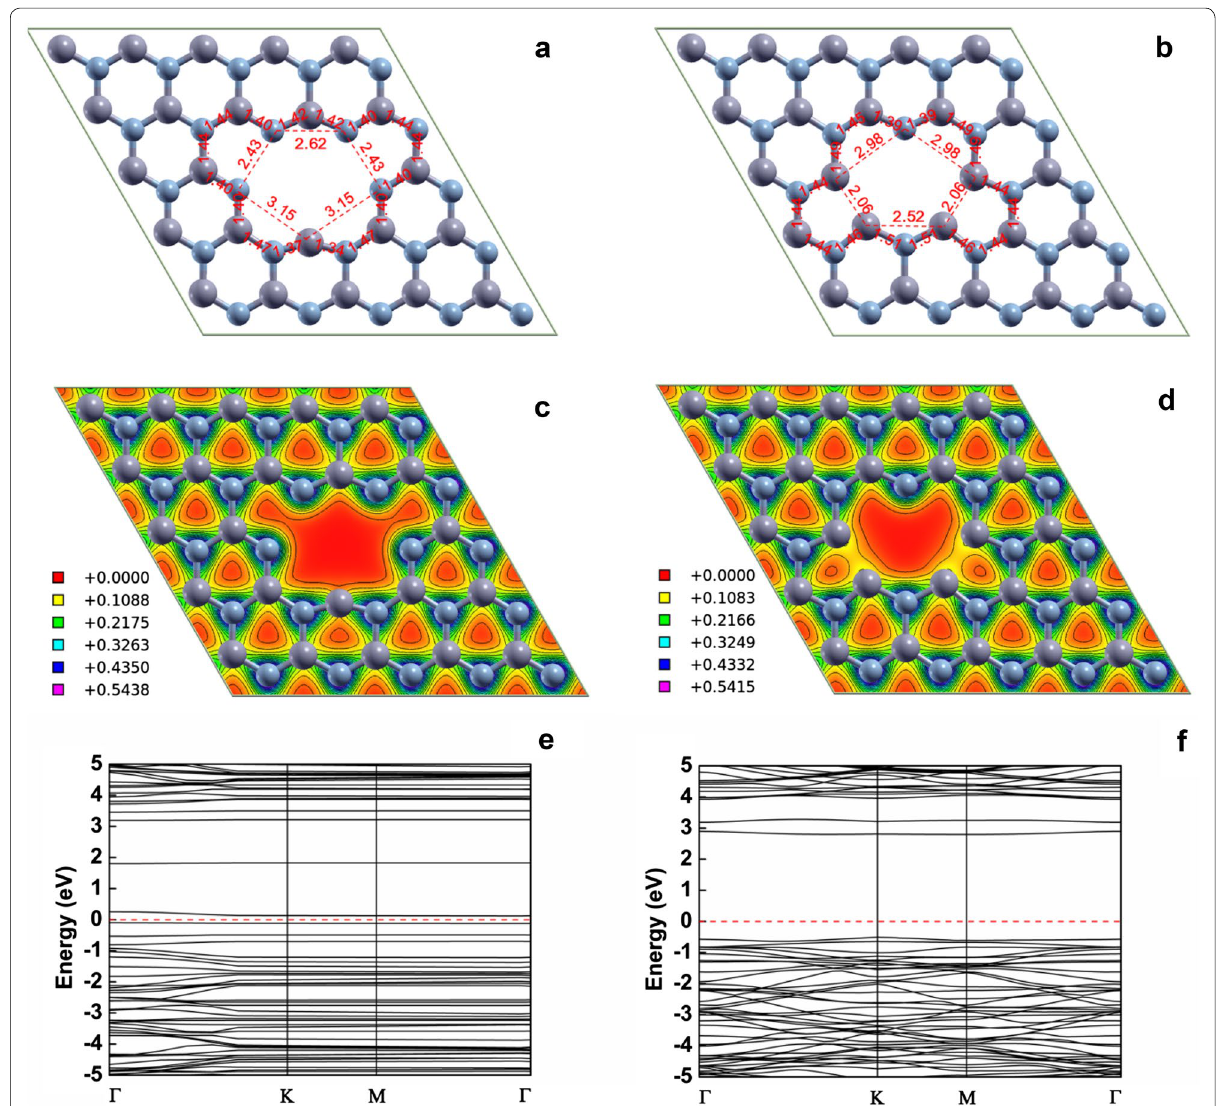
Fig. 5 The left column shows a relaxed structure, b isodensity plot, and c electronic band structure of h‑BN with 3V 2BN , and the right column displays b relaxed structure, d isodensity plot, and f electronic band structure of h‑BN with 3V 2NB . The Fermi level is set to be